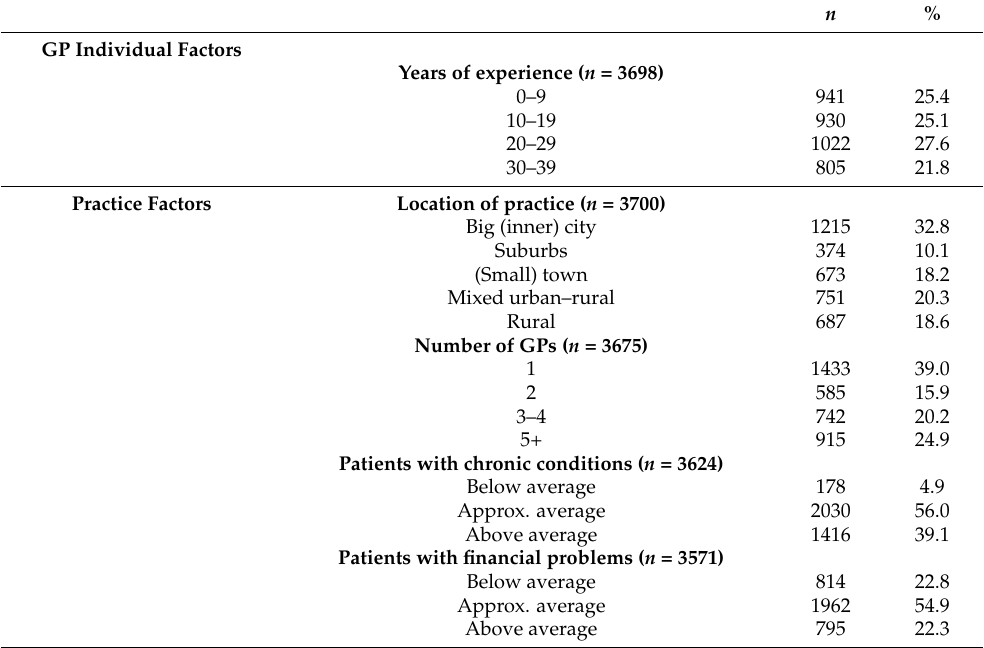
Table 1. Main characteristics of the general practitioners and their practices during the COVID-19 pandemic ( n = 3711).